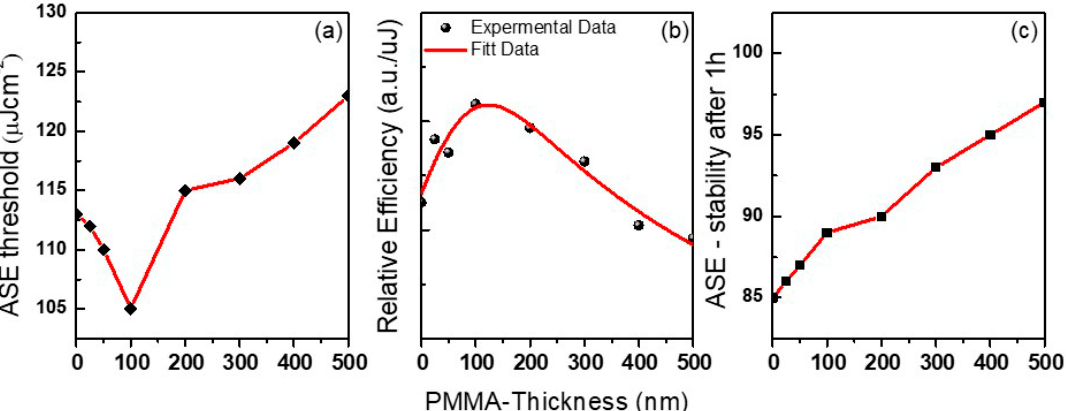
Figure 10. ( a ) Amplified spontaneous emission (ASE) energy density threshold; ( b ) relative efficiency of fitted lines beyond the threshold in intensity-pump energy depending on the curves as a function of the energy density; and ( c ) ASE intensity under laser shot for 1 h (54,000 shots) as a function of the thicknesses of polymethyl methacrylate (PMMA) as a passivation layer top of CsPb(Br 0 . 5 Cl 0 . 5 ) 3 thin films.